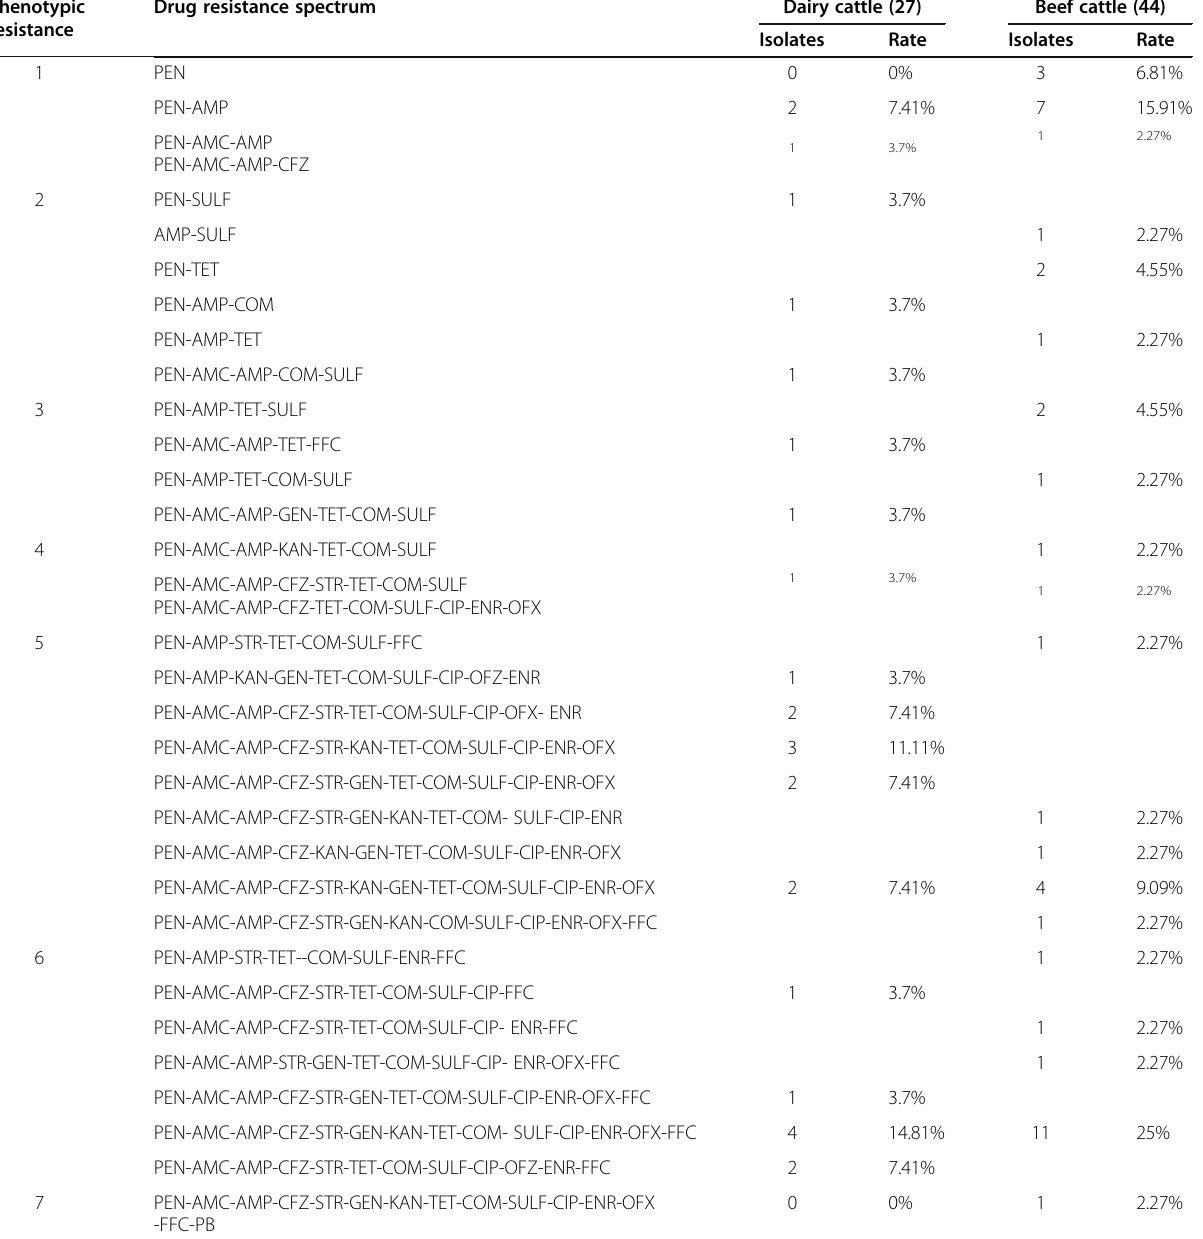
Table 1 Various antimicrobial resistance patterns in 71 E. coli isolates from dairy cattle ( n = 27) and beef cattle ( n = 44) Phenotypic